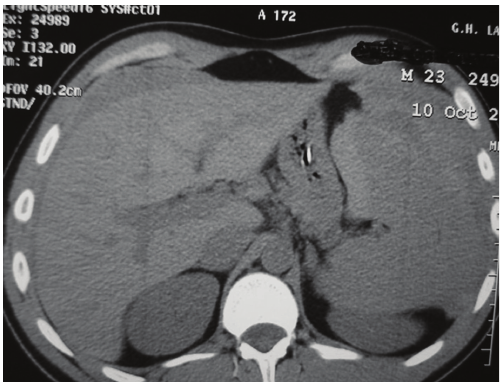
Figure 1: Preoperative CT scan indicative of the splenic rupture and